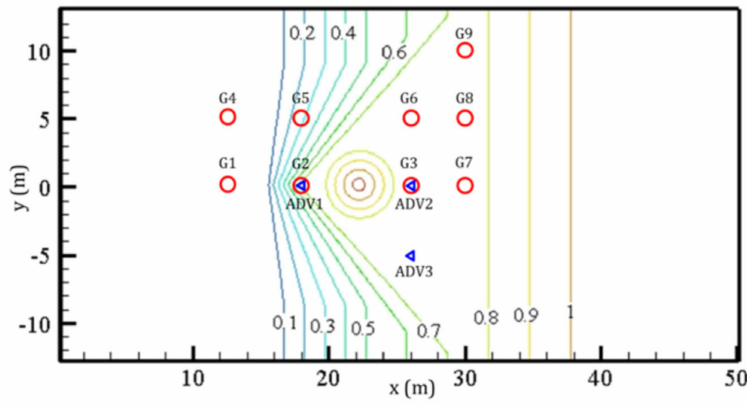
Figure 14. Bathymetry contours and locations of measuring points. Circles (water surface measure-